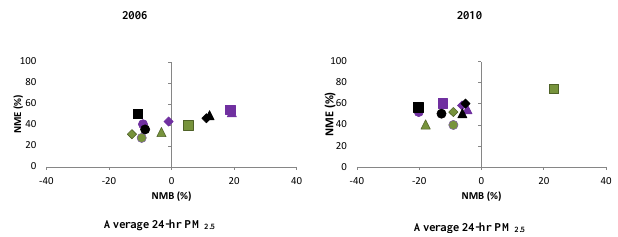
Figure 6. Comparison of seasonal plots of NMB vs. NME for av- erage 24h PM 2 . 5 concentrations where the different shapes repre- sent different seasons (diamond – MAM, circle – JJA, triangle – SON and square – JFD) and the different colors represent different observational data (purple – IMPROVE, black – STN and green –